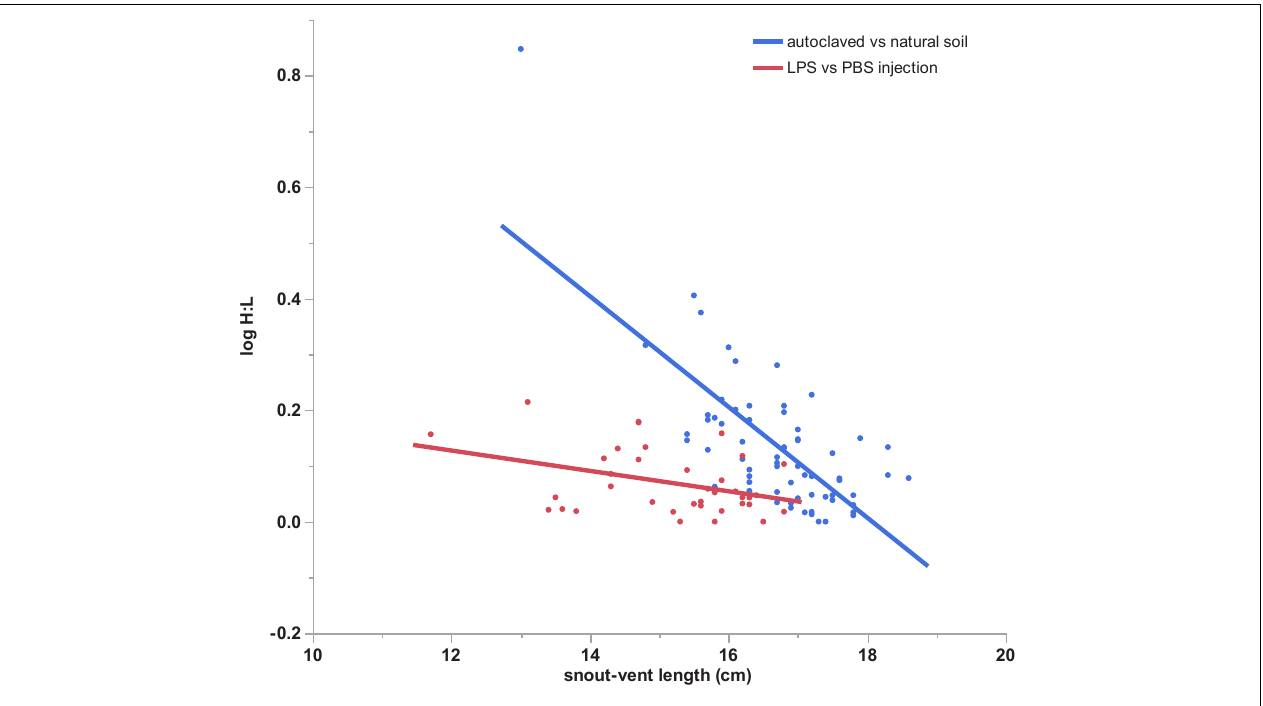
FIGURE 4 | Effects of hatchling body size (SVL, snout-vent length) of keelback snakes ( Tropidonophis mairii ) on heterophil:lymphocyte (H:L) ratios. H:L ratio decreased significantly with snout-vent length (SVL) in both experiments.